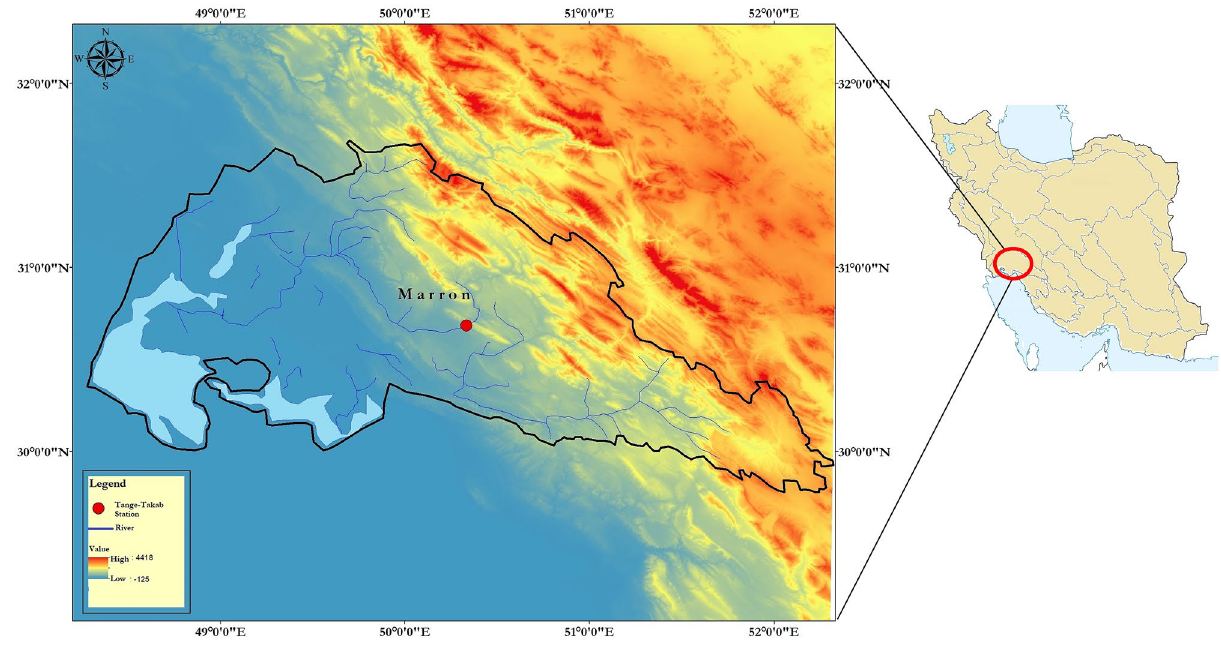
Figure 3. Location of Tange-Takab